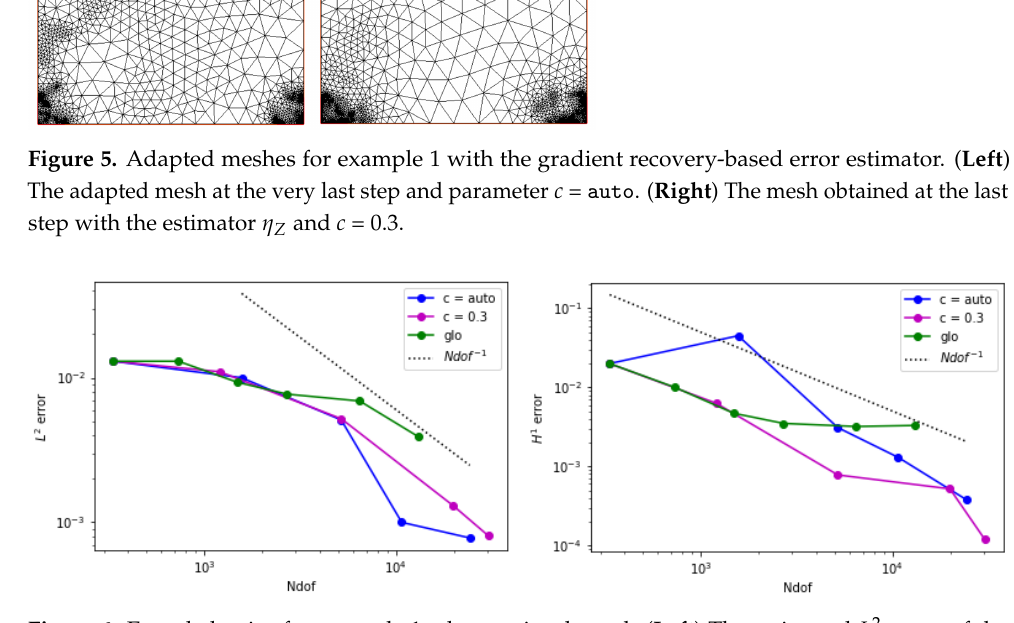
Figure 6. Error behavior for example 1 when η Z is adopted. ( Left ) The estimated L 2 norm of the error is displayed. ( Right ) The estimated H 1 seminorm is shown.